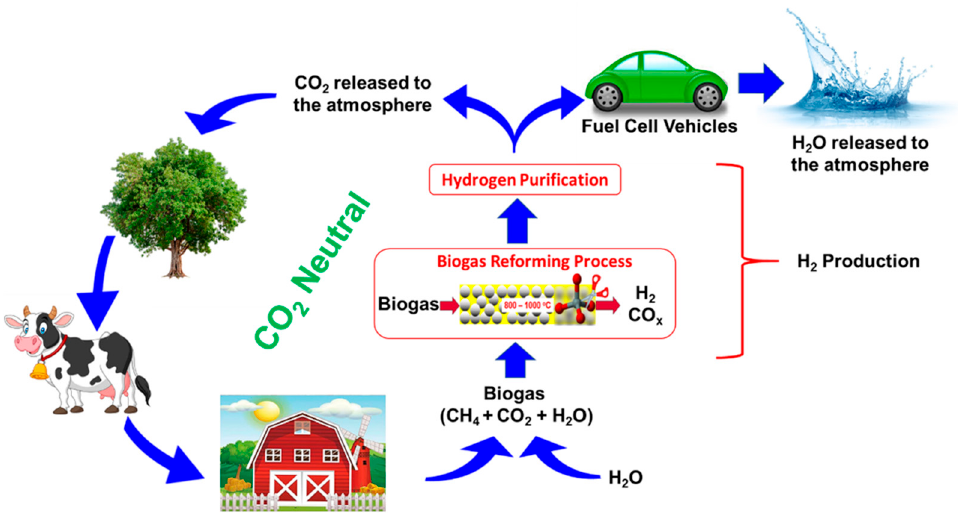
Figure 1. Schematic of biogas energy cycle.